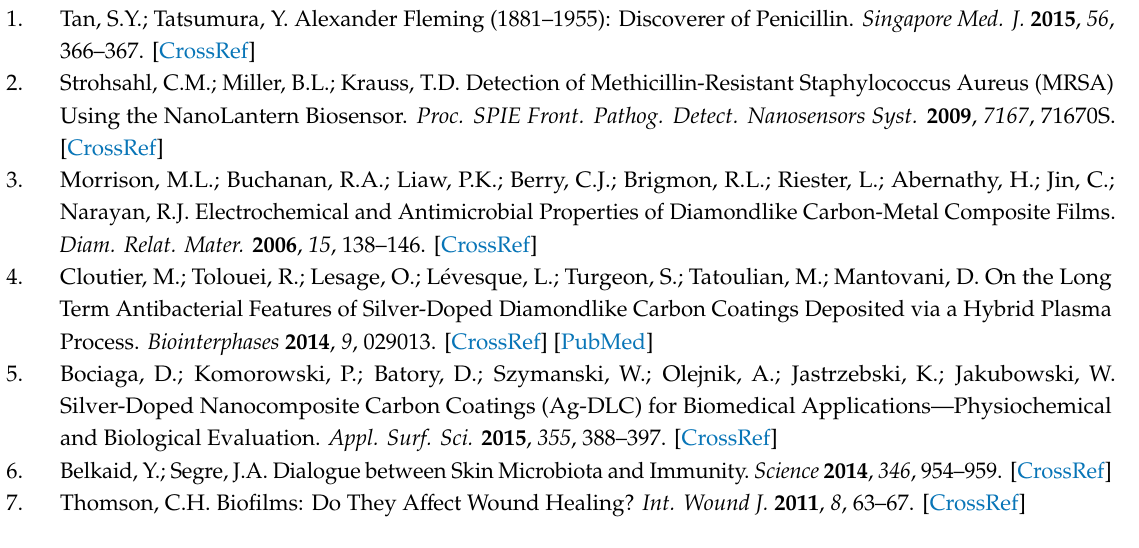
Table S1: Antimicrobial properties of RF oxygen plasma-processed DLC:Ag film on silk containing 3.4 at.% of Ag. The dilution of bacteria (0.5 Mf) was 10 − 5 and active contact surface was 6 cm 2 / mL. Control test was performed with synthetic silk fabric 6 cm 2 / mL. The samples were thermostated at 35 ◦ C temperature, Table S2: Fit parameters of the CFU (Figure 2) using equation y = y 0 + A exp( t / τ ) where y is CFU, t is the time, y 0 is the o ff set, A is the initial value, R 0 = 1 / τ is the decay rate and τ is the decay constant) and silver ion concentration using equation y = ln( a + bt ) ( y is silver ion concentration, t is the time, a and b are fittable parameters). χ 2 and R 2 are goodness of the fit. Std.E. stands for Standard Error, Table S3: Antimicrobial properties of silver saturated water containing three di ff erent silver ion concentrations: 1 ppm, 3 ppm and 4 ppm. The dilution of bacteria was 10 − 5 . Control test was performed with bacteria solution without silver. The samples were thermostated at 35 ◦ C